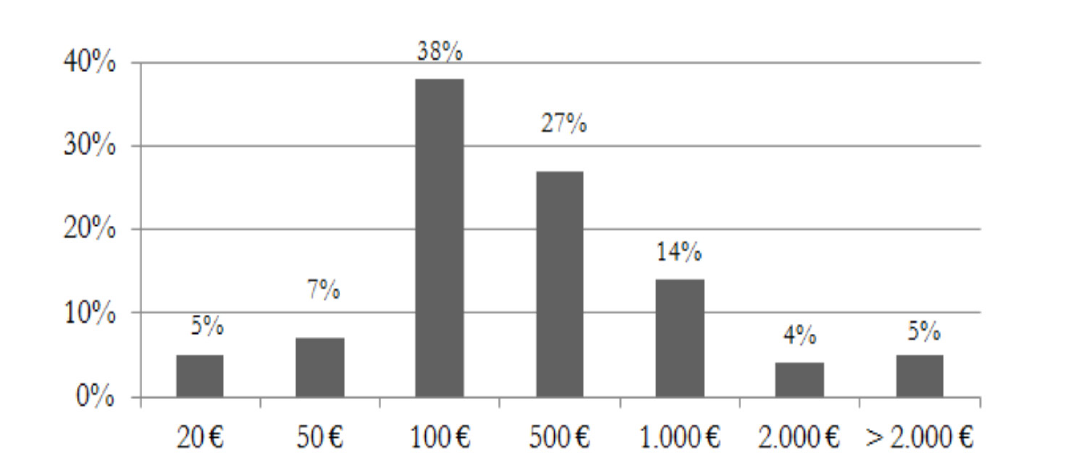
Figure 4: Extent of willingness to pay for noise abatement (N =